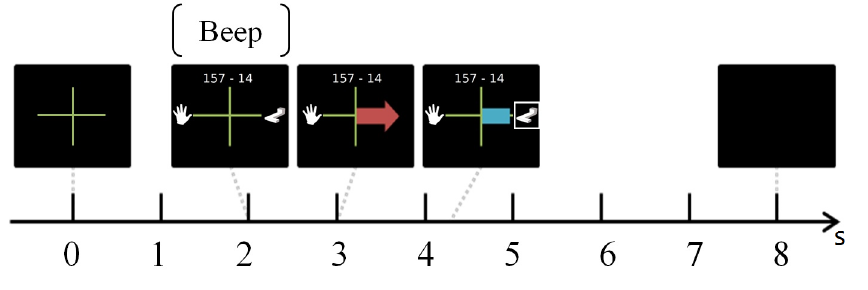
Fig 1. Timing of the